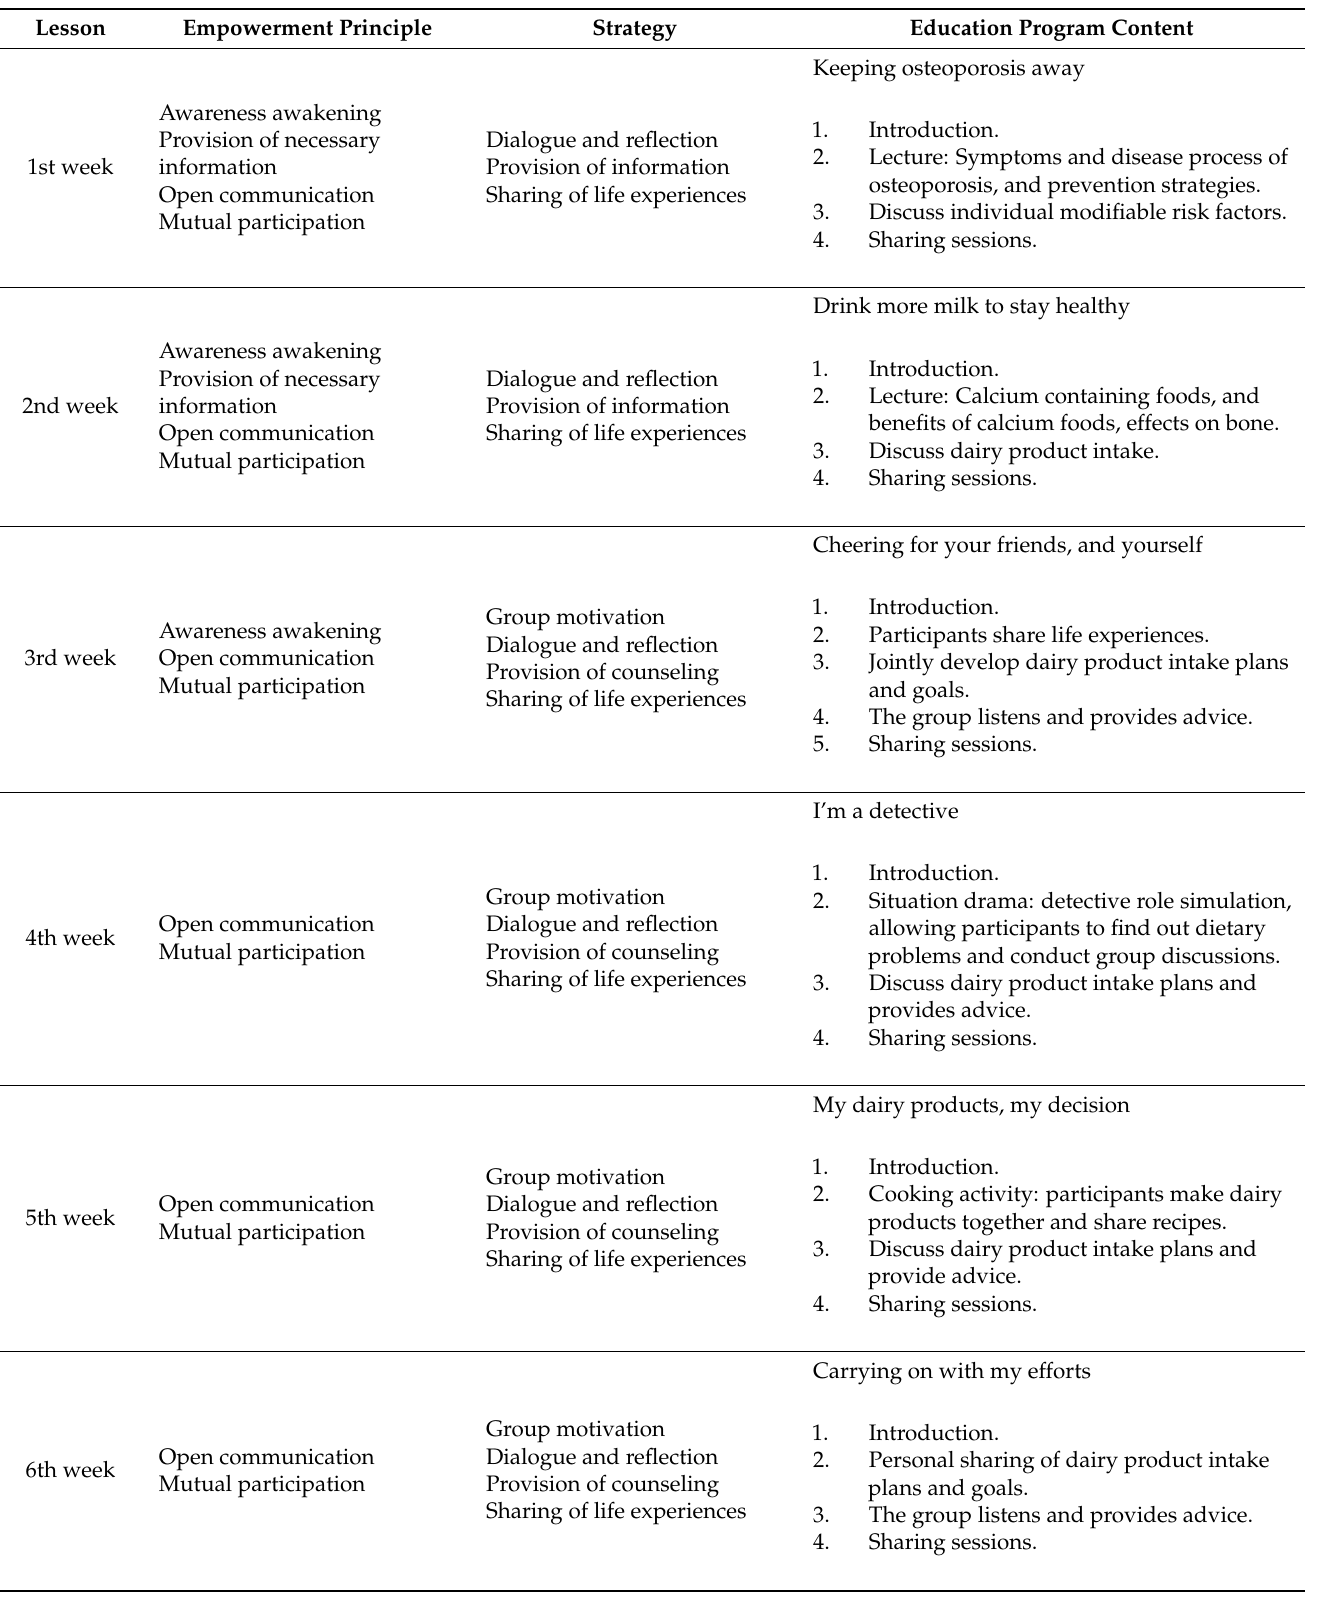
Table 1. Empowerment education